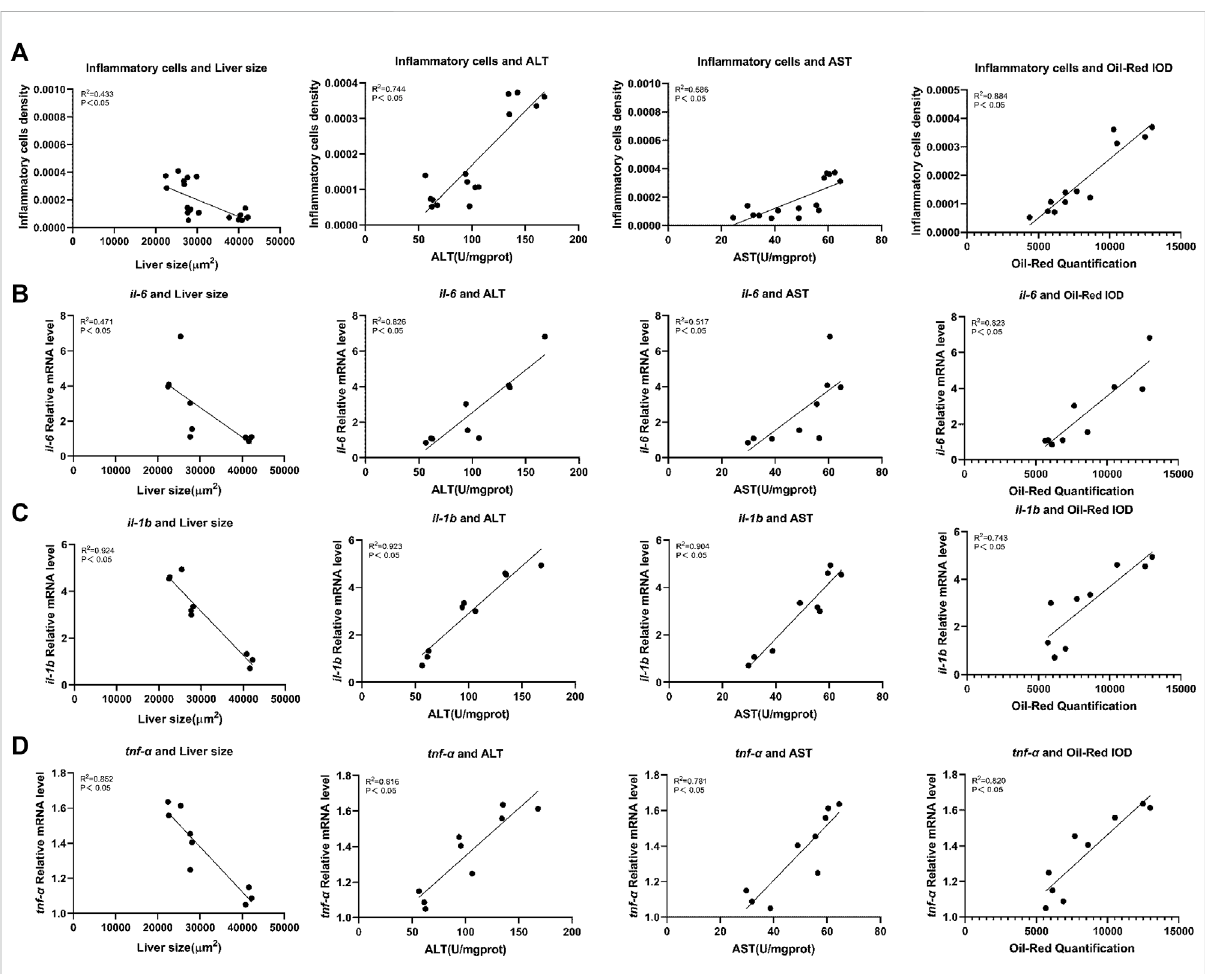
FIGURE 6 Correlation analysis of in fl ammation-related factors with liver toxicity indicators in zebra fi sh. (A) In fl ammatory cells density. (B) mRNA expressionlevelsof il-6. (C) mRNAexpressionlevelsof il-1b. (D) mRNAexpressionlevelsof tnf- α . Livertoxicityindicators:liver fl uorescencearea,ALT and AST activity values, and optical density of Oil red O staining (Integrated Optical